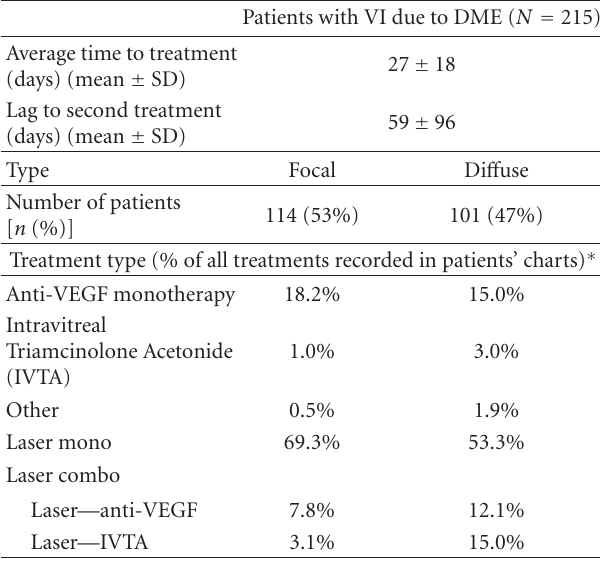
Table 5: Treatment characteristics of patients with VI due to